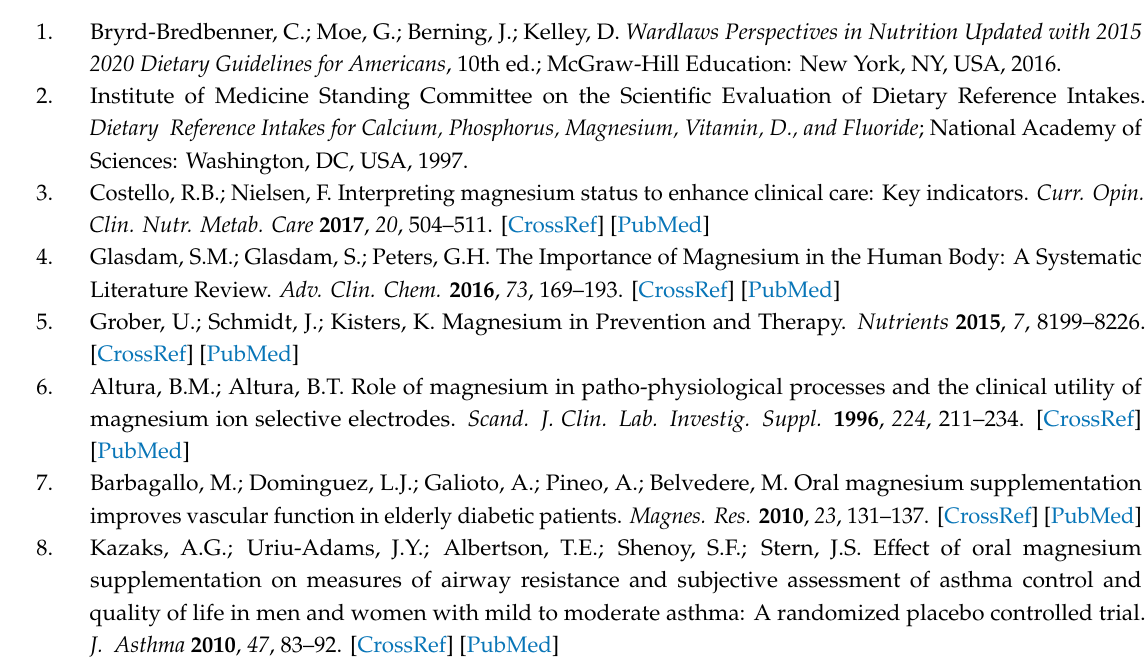
Figure S1: title, Table S1: Ten-week change in ionized and total magnesium concentrations by treatment group and stratified by baseline magnesium concentrations, Table S2 Ten-week change in ionized and total magnesium concentrations by treatment group, overall and stratified by baseline magnesium concentrations, excluding those who did not take > 80% capsules as assigned, n =